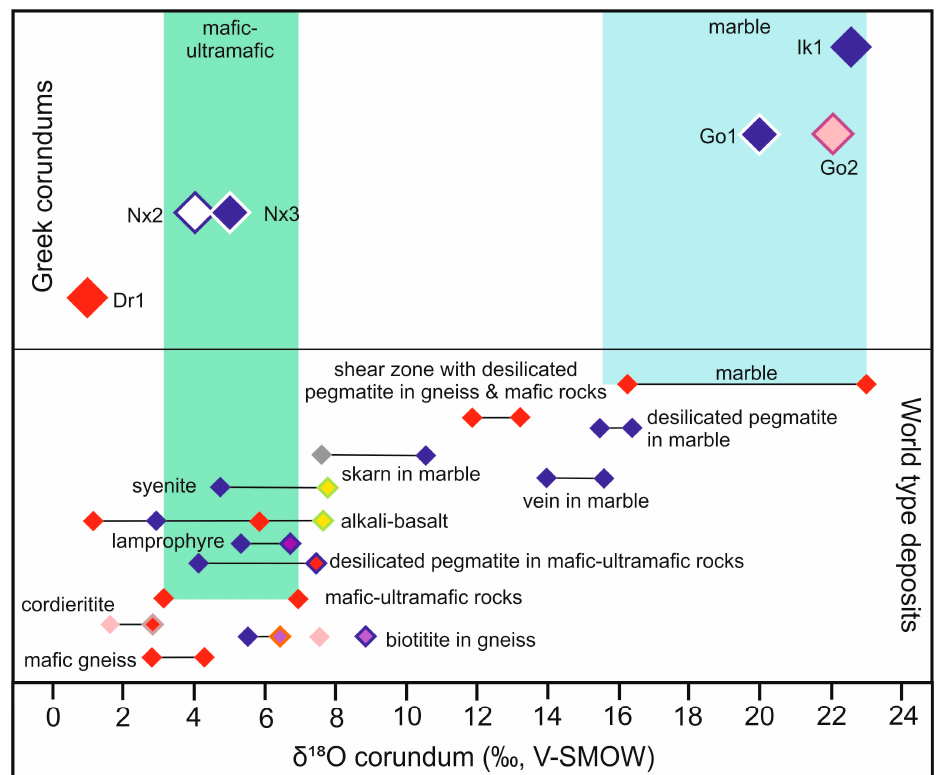
Figure 8. Oxygen isotopic composition of Greek corundum (after Wang et al. [83]) compared with the oxygen isotopic ranges from corundum deposits worldwide from the data of Giuliani et al. [2,7,14,81,82]. Color in diamonds represents the color of the studied corundums. Colorless sapphires are represented by white diamonds.